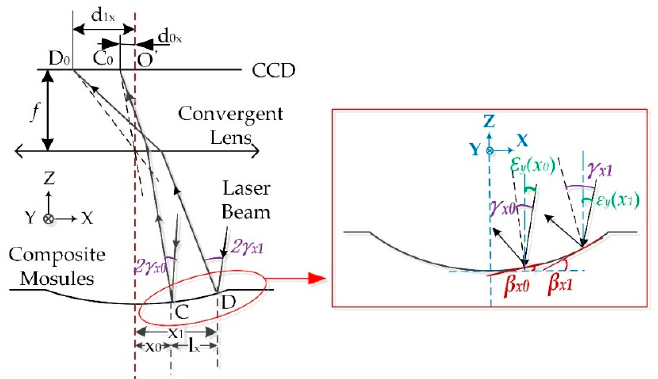
Figure 5. XOZ section of the measurement system, when detected at the rotating paraboloid surface. The incident beam is emitted to the paraboloid surface, then the reflected beam forms a spot 𝐶 (cid:2868) on the CCD. When the incident beam moves from point C to D, the imaging point of the reflective beam on the CCD moves from point 𝐶 (cid:2868) to 𝐷 (cid:2868) . Equation (12) can be derived from the principle of laser collimation.